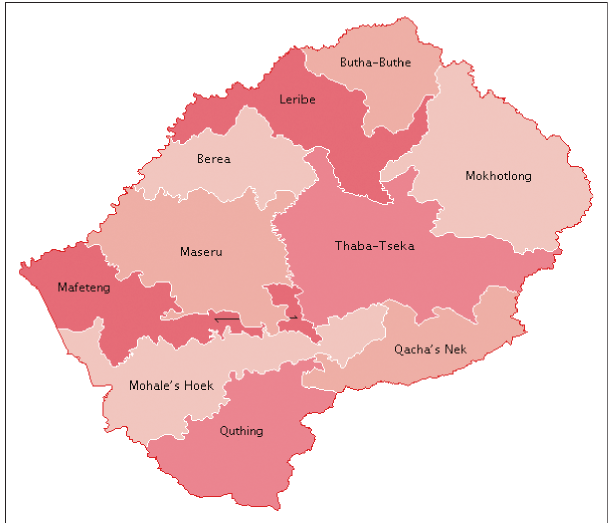
FIGURE 1: Administrative divisions map of Lesotho, showing 10